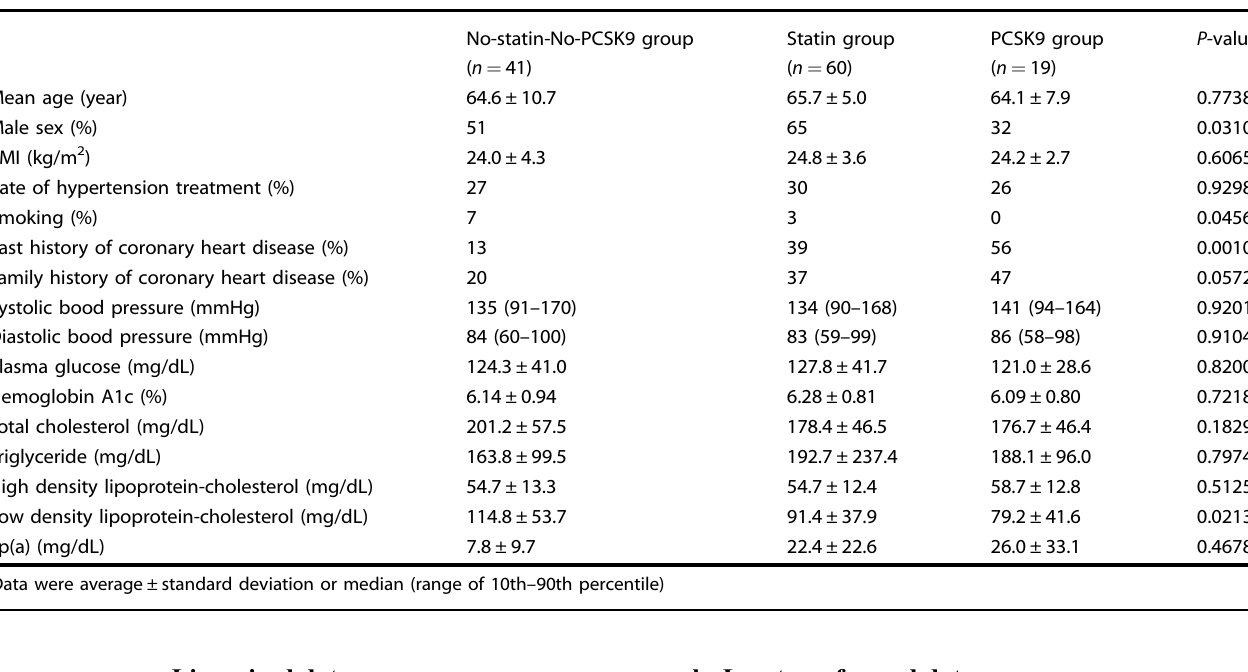
Table 2. Baseline characteristics of the unpaired cross-sectional